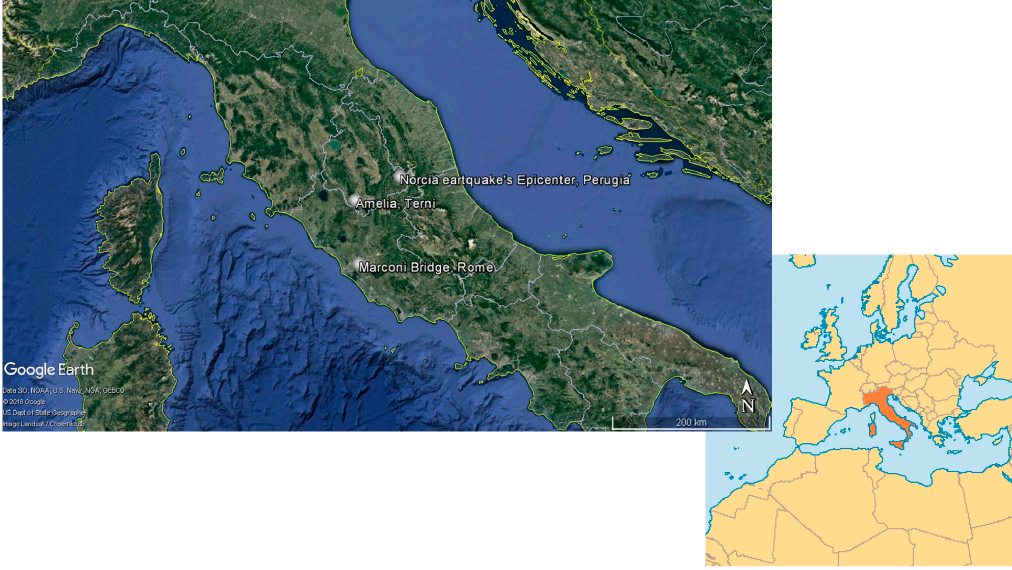
Figure 1. The epicenter of the Norcia 2016 earthquake and the two areas in which the GPR investigations were performed (source: Google Earth).